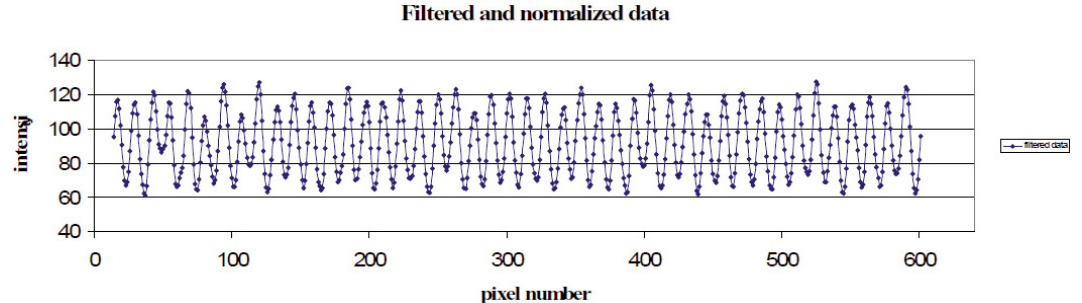
Fig. 1. A plot of the intensity distribution of the grating image versus pixels (in one direction) after filtering and normalization